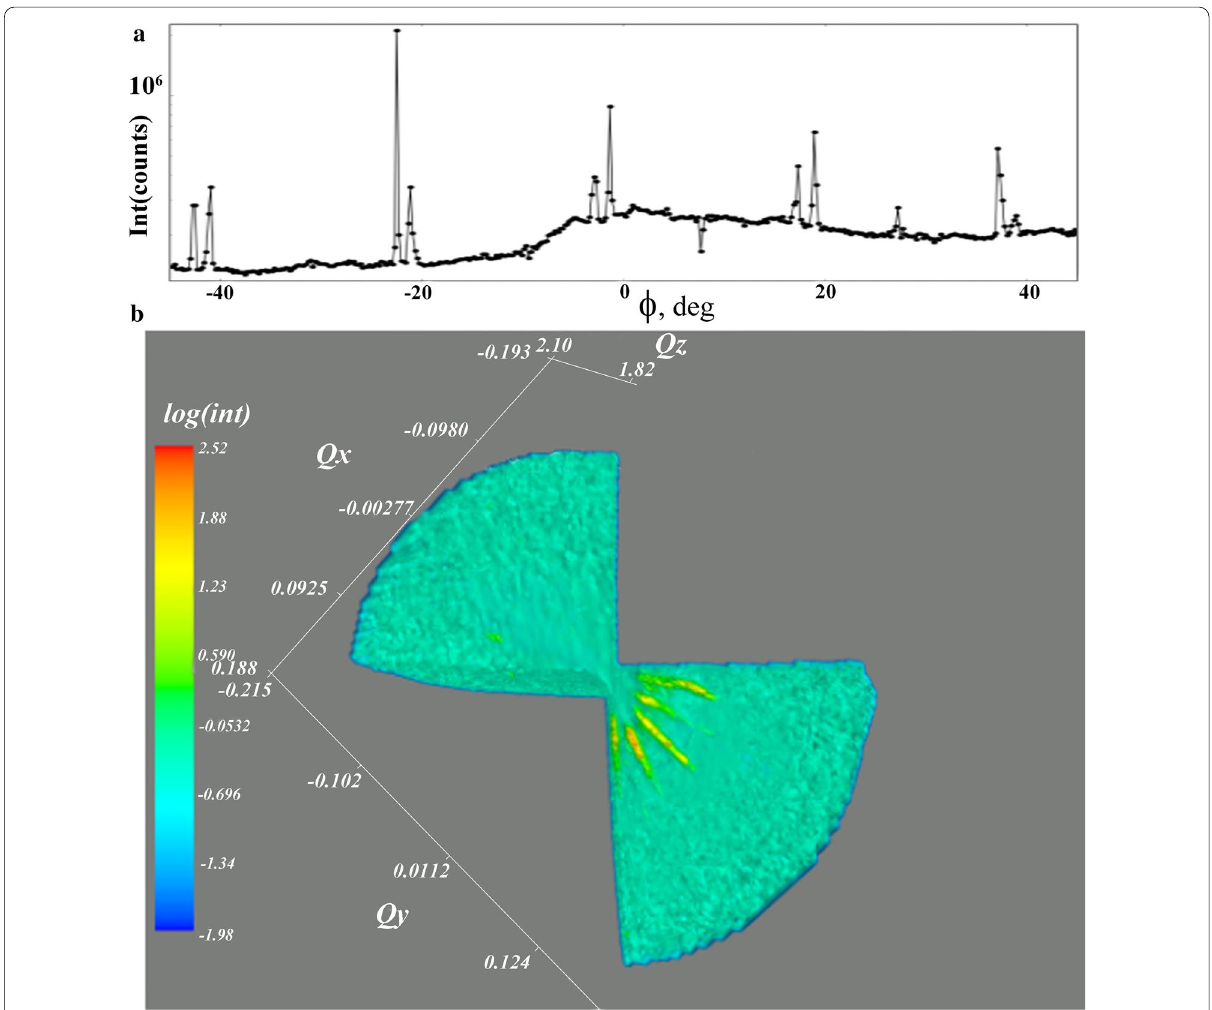
Fig. 4 a Synchrotron X-ray φ -scan diffraction pattern of the narrow BDD plate. b Reciprocal space representation of wave vectors from 2D layered structure with the period of 6.18 Å (yellow